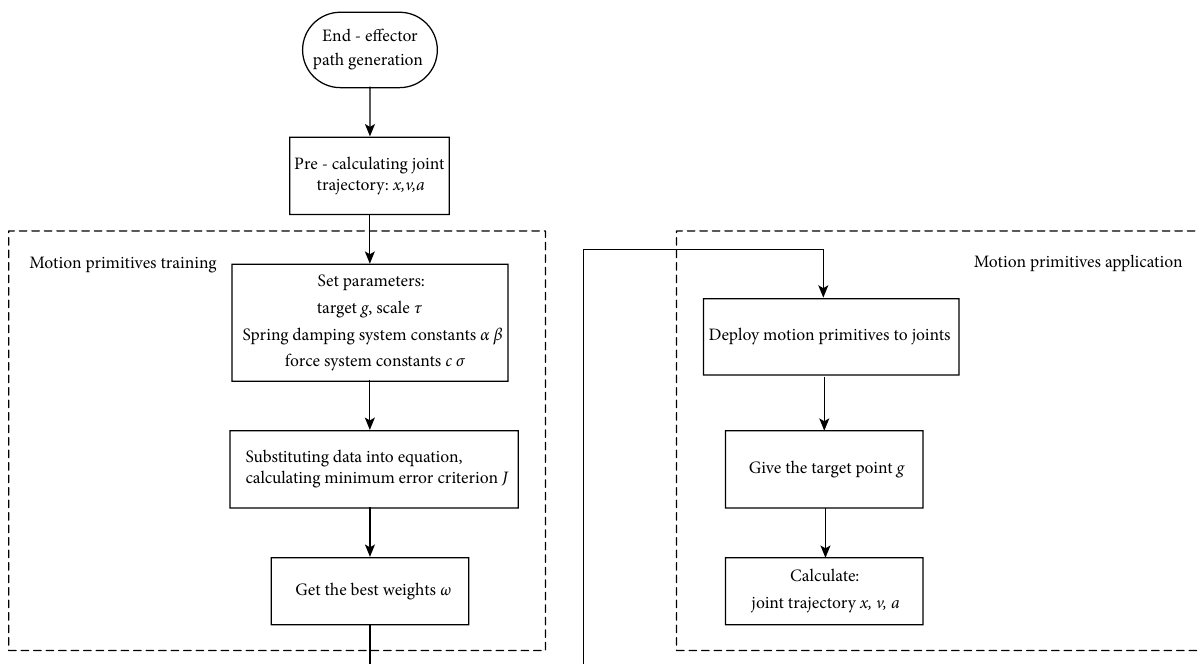
Figure 2 : The DMP algorithm flowchart.